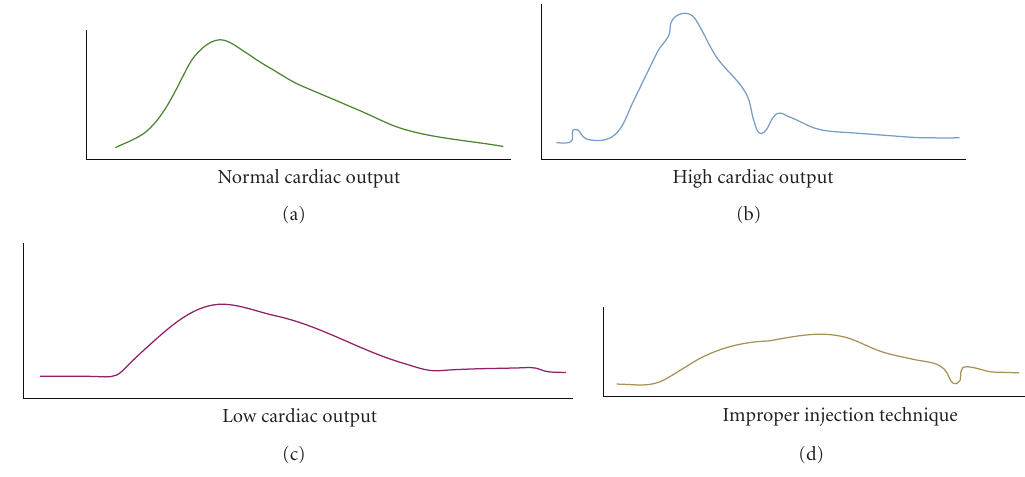
Figure 1: Thermodilution cardiac output curves. Used with permission from